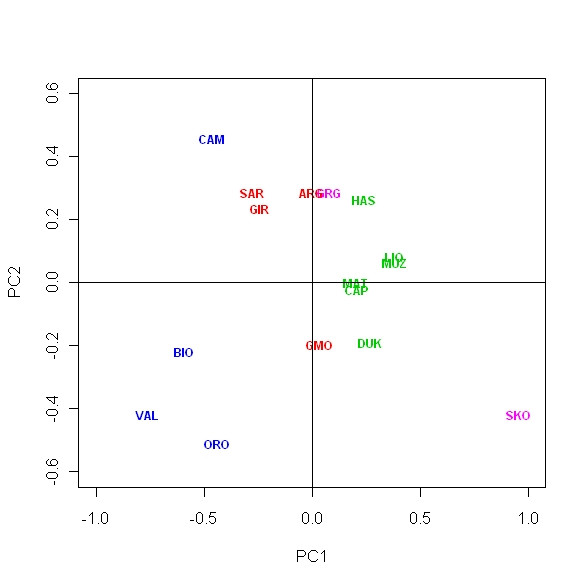
Principal component analysis (PCA) of allele frequencies from twenty six SNP loci genotyped in the sixteen goat breeds. Projection on axis 1 and axis 2, which cumulatively explained 56.8% of the total inertia contained in the data set. Breeds acronyms as in Table 1. Albanian breeds, green; North Italian breeds, blue; South Italian breeds, red; Greek breeds, pink.